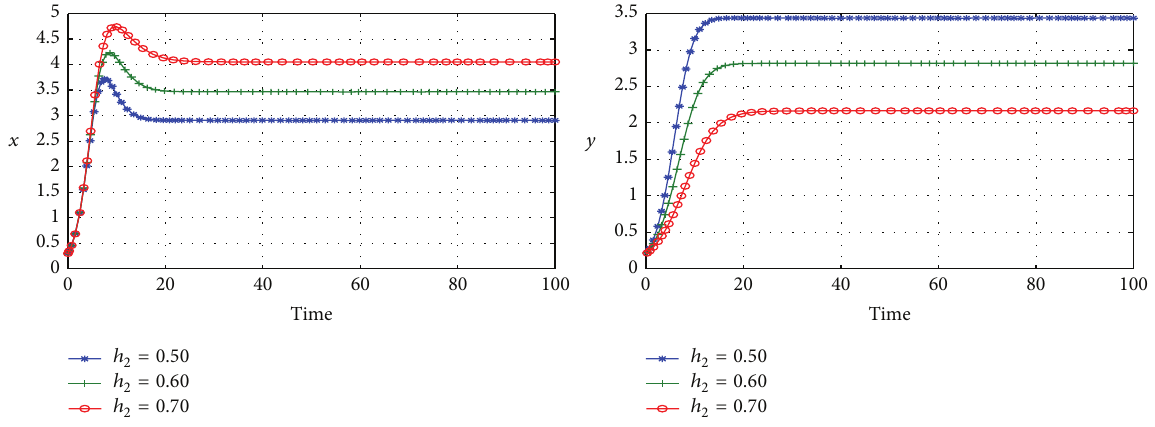
Figure 2: When ℎ 1 = 0.4 and ℎ 2 increases, prey species 𝑥 increases and predator species 𝑦 decreases.